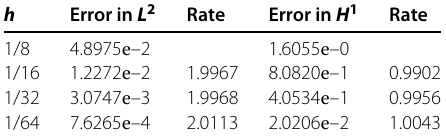
Table 1 The errors and convergence rates of u – u hk in the L 2 and H 1 norms concerning h at t = 1 h Error in L 2 Rate Error in H 1